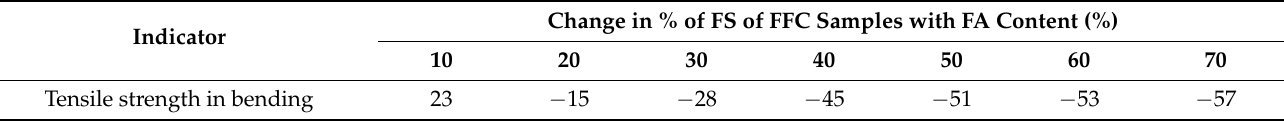
Table 10. Change in FS of FFC samples depending on the percentage of